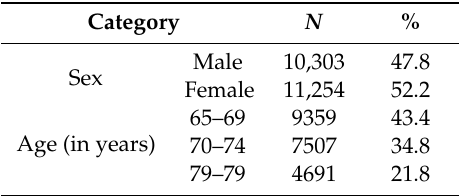
Table 1. Descriptive statistics of the sample ( N = 21,557).